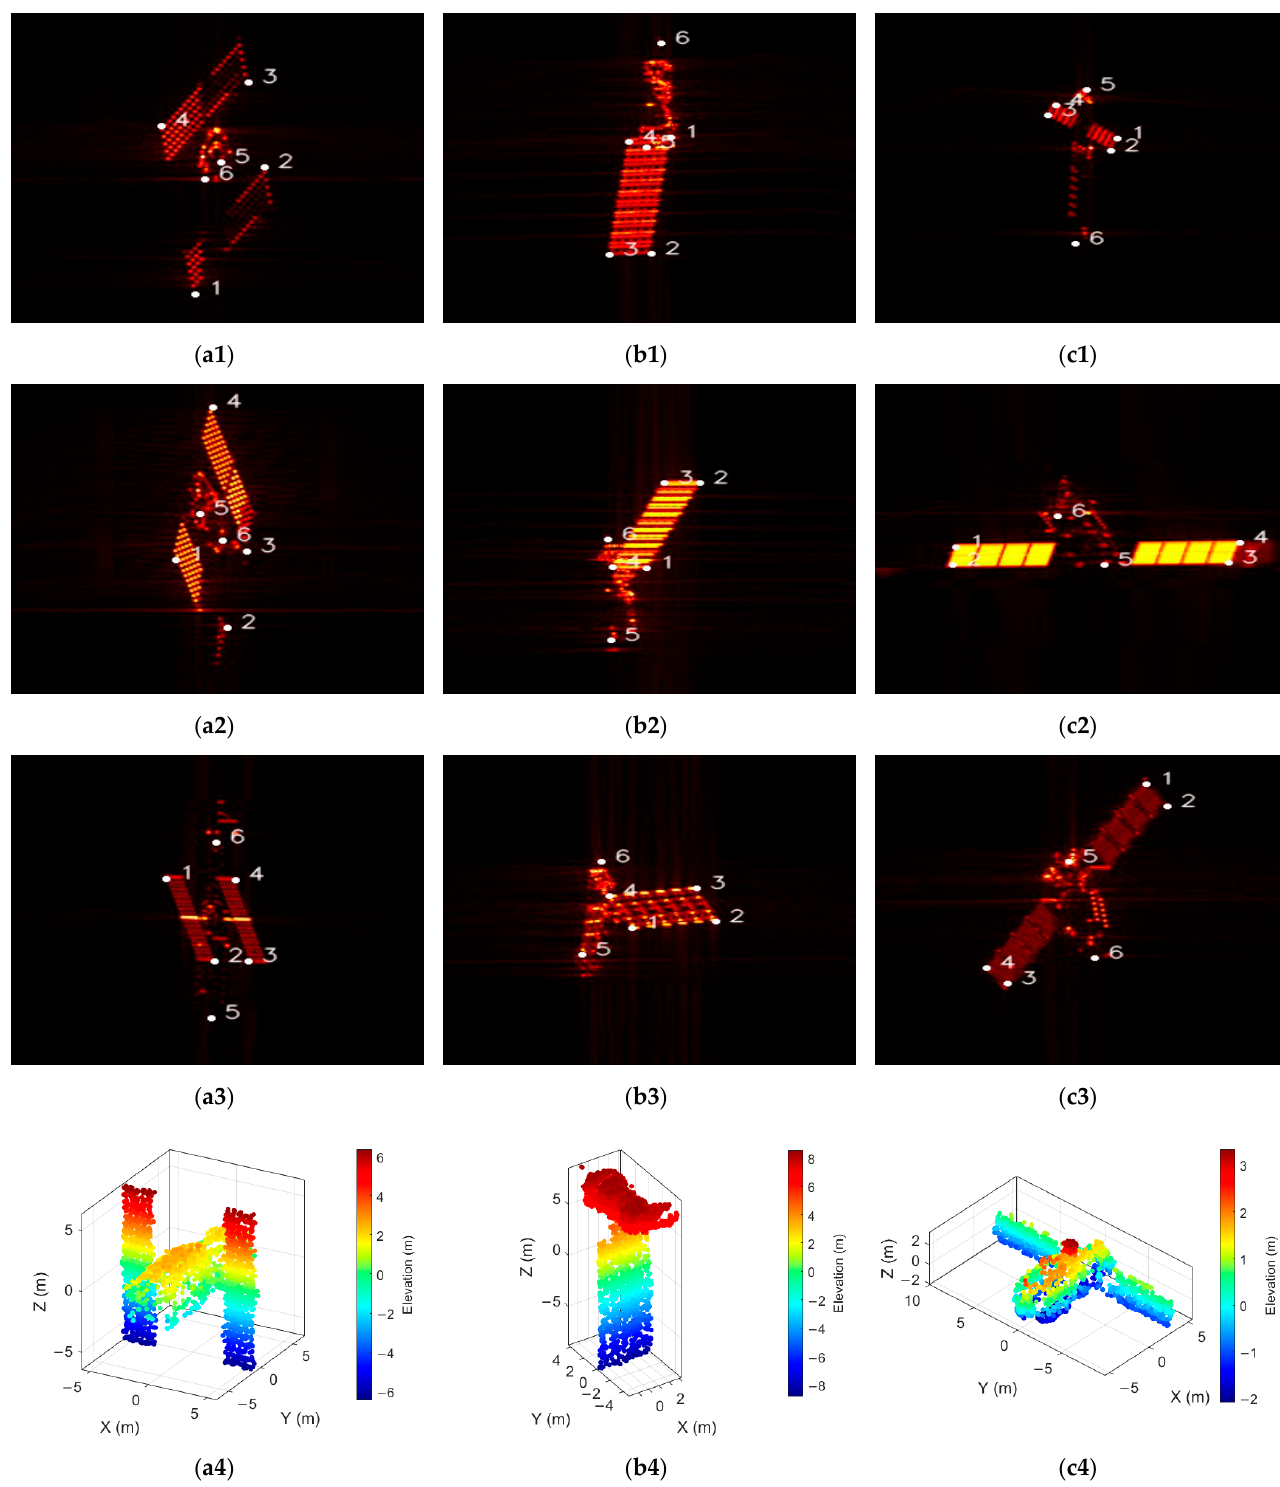
Figure 7. The 2D ISAR images and corresponding key points extraction of ( a1 – a3 ) HST, ( b1 – b3 ) Aqua, and ( c1 – c3 ) Tiangong-1, as well as the reconstructed 3D point clouds of ( a4 ) HST, ( b4 ) Aqua, and ( c4 ) Tiangong-1. To train the KeyPoint R-CNN, for each satellite, 5000 ISAR images from different views were obtained as the dataset, 90% of which were used as the training dataset, while